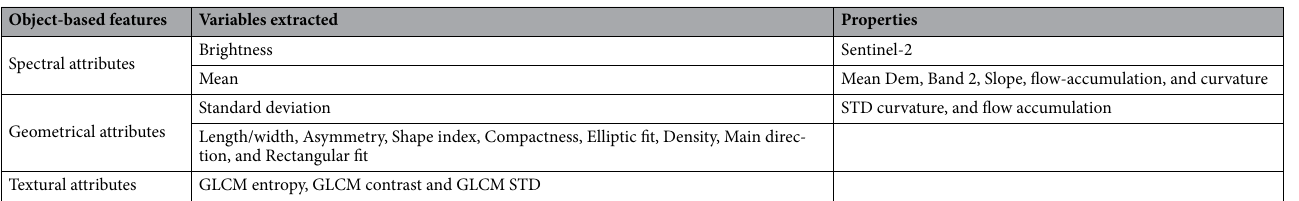
Table 4. Various spectral, geometrical and textural features relevant to delineating volcanic and glacial landforms and their